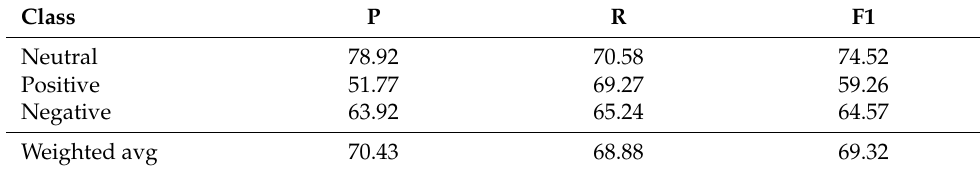
Table 4. Performance of the Baseline